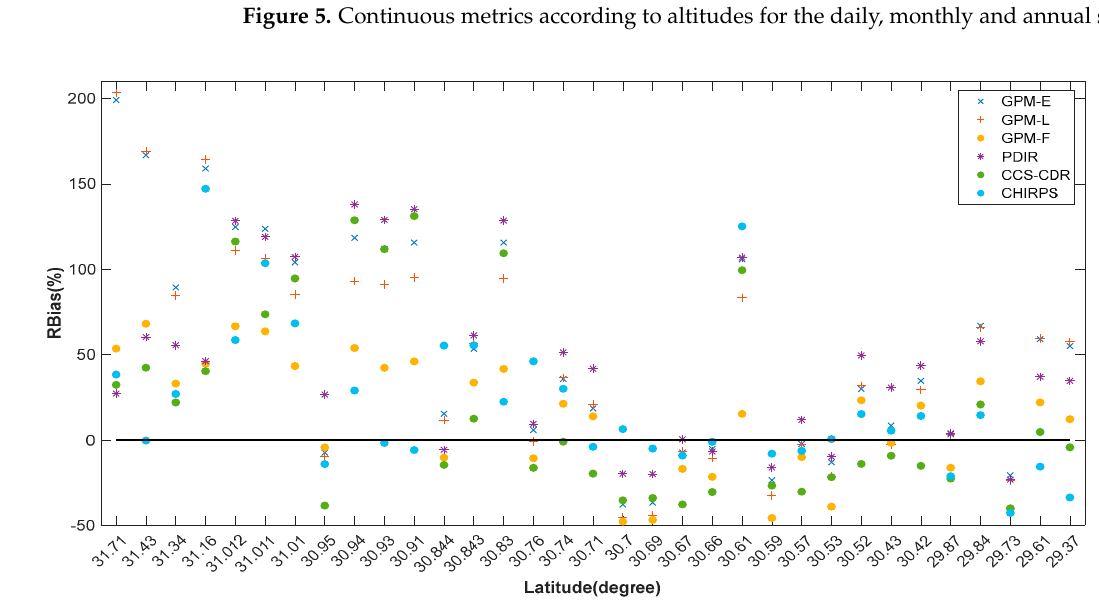
Figure 5. Continuous metrics according to altitudes for the daily, monthly and annual scales.